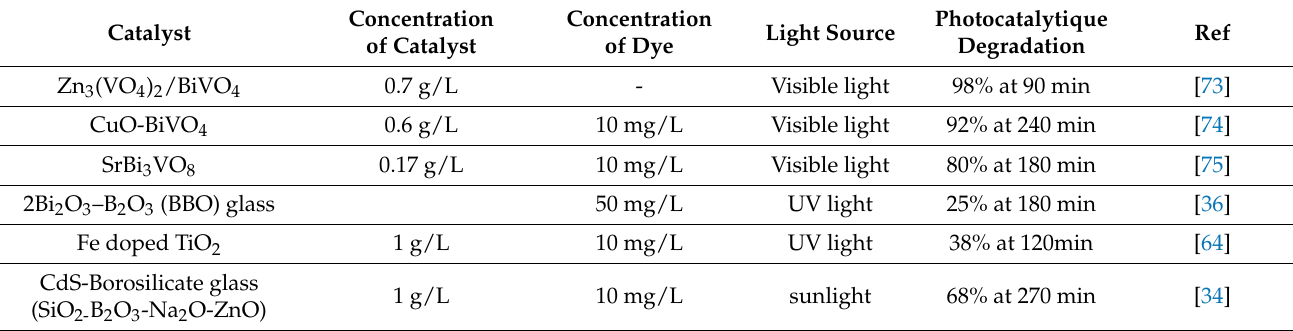
Table 2. Comparison with the state-of-the-art photocatalysts for MB degradation.